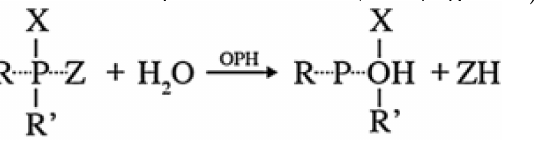
Figure 14. The reaction scheme demonstrates the pesticides reaction triggers the dissociation of